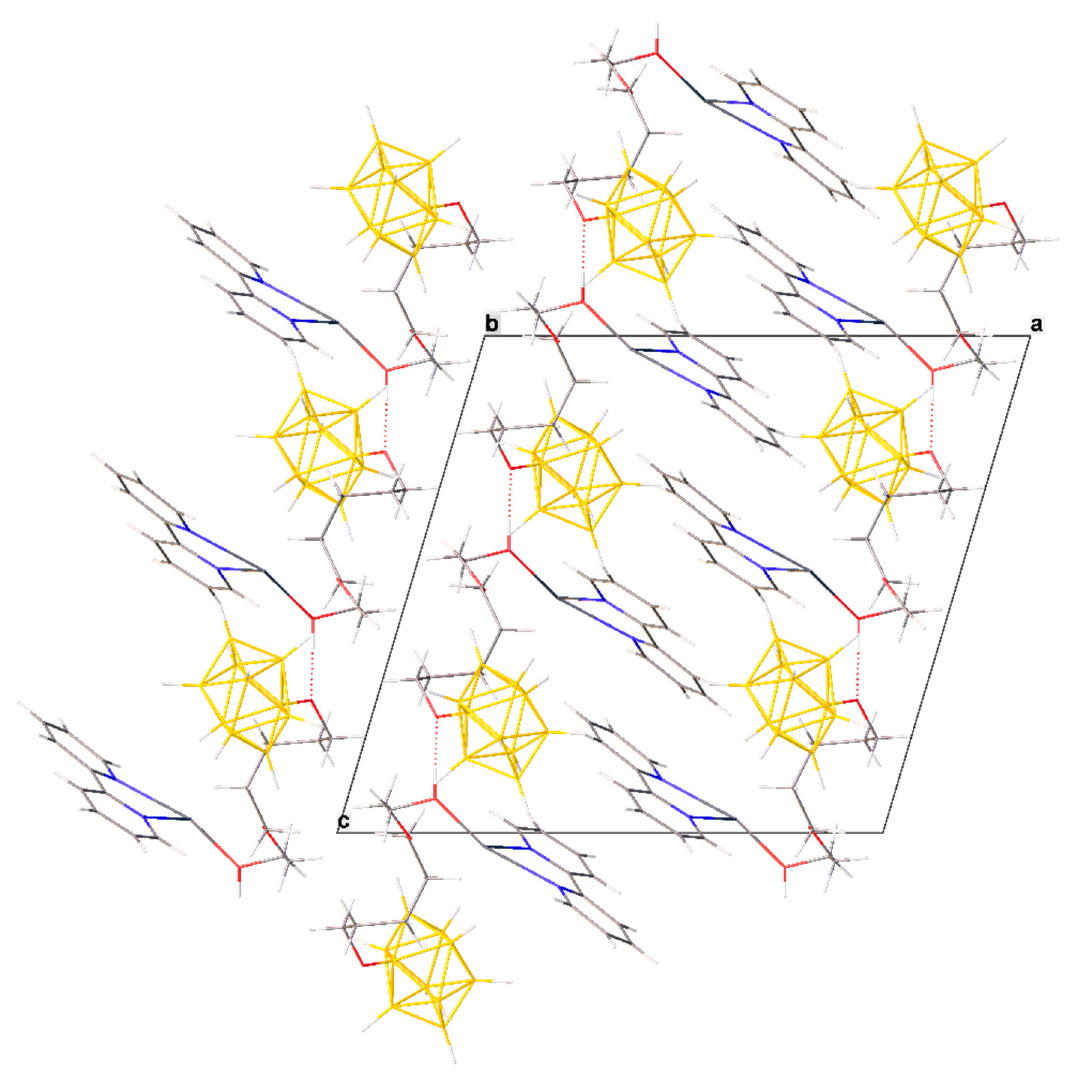
Figure 6. Packing diagram of 3 .